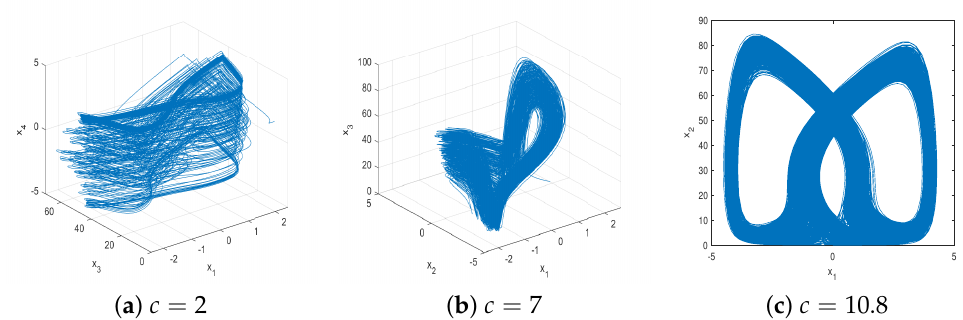
Figure 15. Phase portraits of system (1) for a = 10, b = 28, d = 0.1 and different c